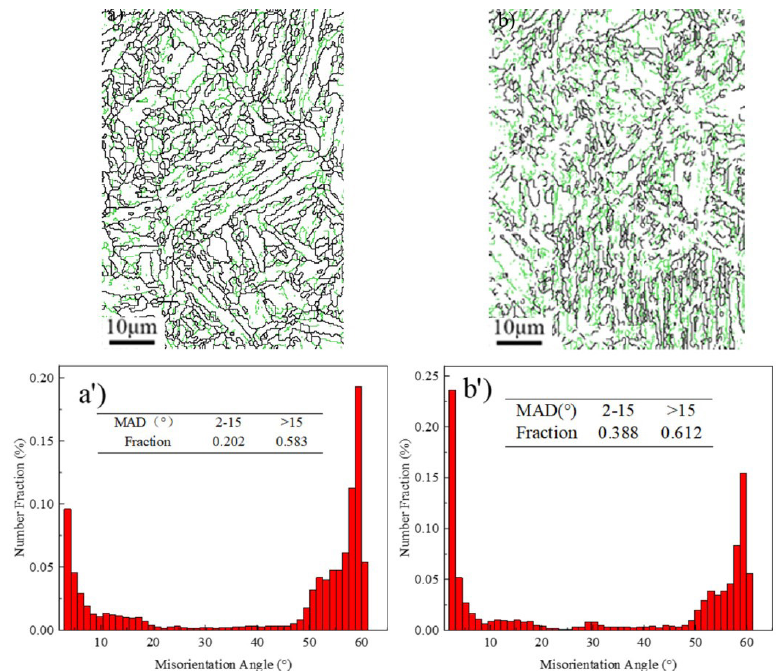
Figure 10. Grain boundary map and orientation angle distribution curves of the material surface before and after USRP treatment (a) and (a’) untreated specimens; (b) and (b’) USRP-treated specimens.